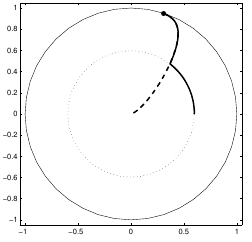
Figure 3. Trajectory p ( t ): Jeffery’s equation (dashed line), sliding model (continuous line). Projection of sphere onto O xy . Wall’s normal is in z